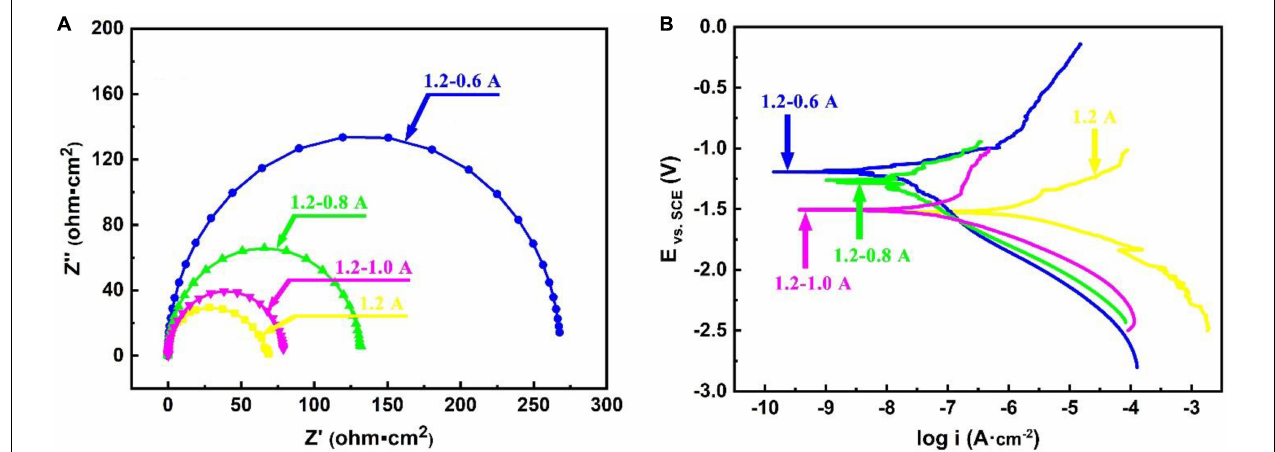
FIGURE 9 | Electrochemical test results of MAO in 3.5 wt.% NaCl solution: (A) Nyquist; (B) polarization curves.